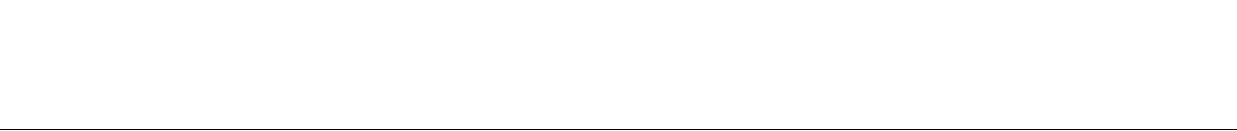
TABLE 4 | Pharmacokinetic parameters of erda fi tinib after oral dose to beagle dogs ( n (cid:2) 6, Means ± SD). Parameters Group A Group B T max